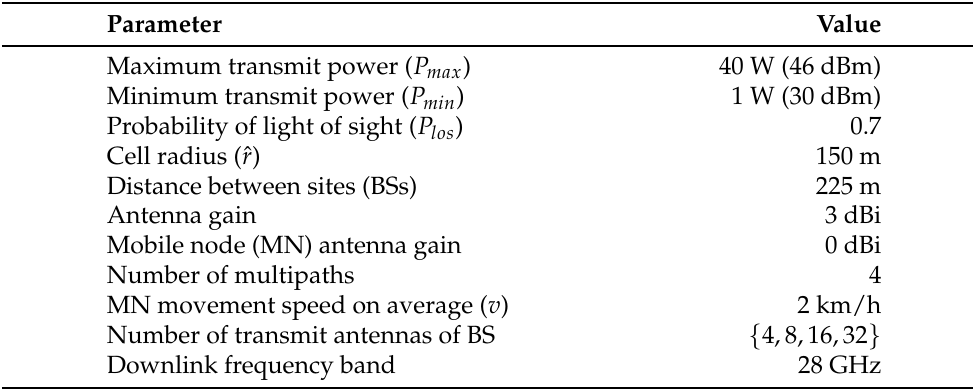
Table 1. Important radio environment